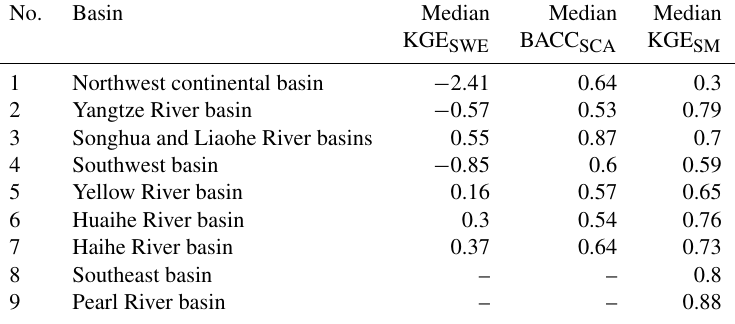
Table 7. Validation of the reconstructed snow water equivalent (SWE) and snow cover area (SCA) in nine major basins of China. The benchmark datasets are SD–CN for SWE, MOD10C1/MYD10C1 for SCA, and SMAP-L4 for SM. KGE: Kling–Gupta efficiency, BACC: balanced